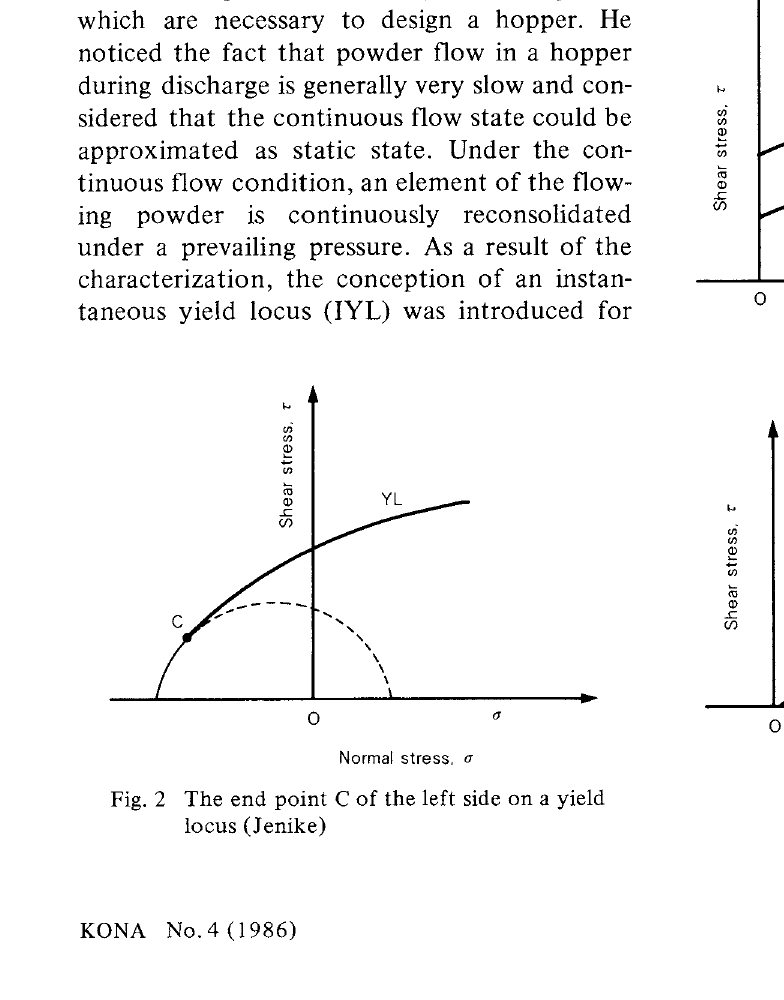
Fig. 2 The end point C of the left side on a yield locus